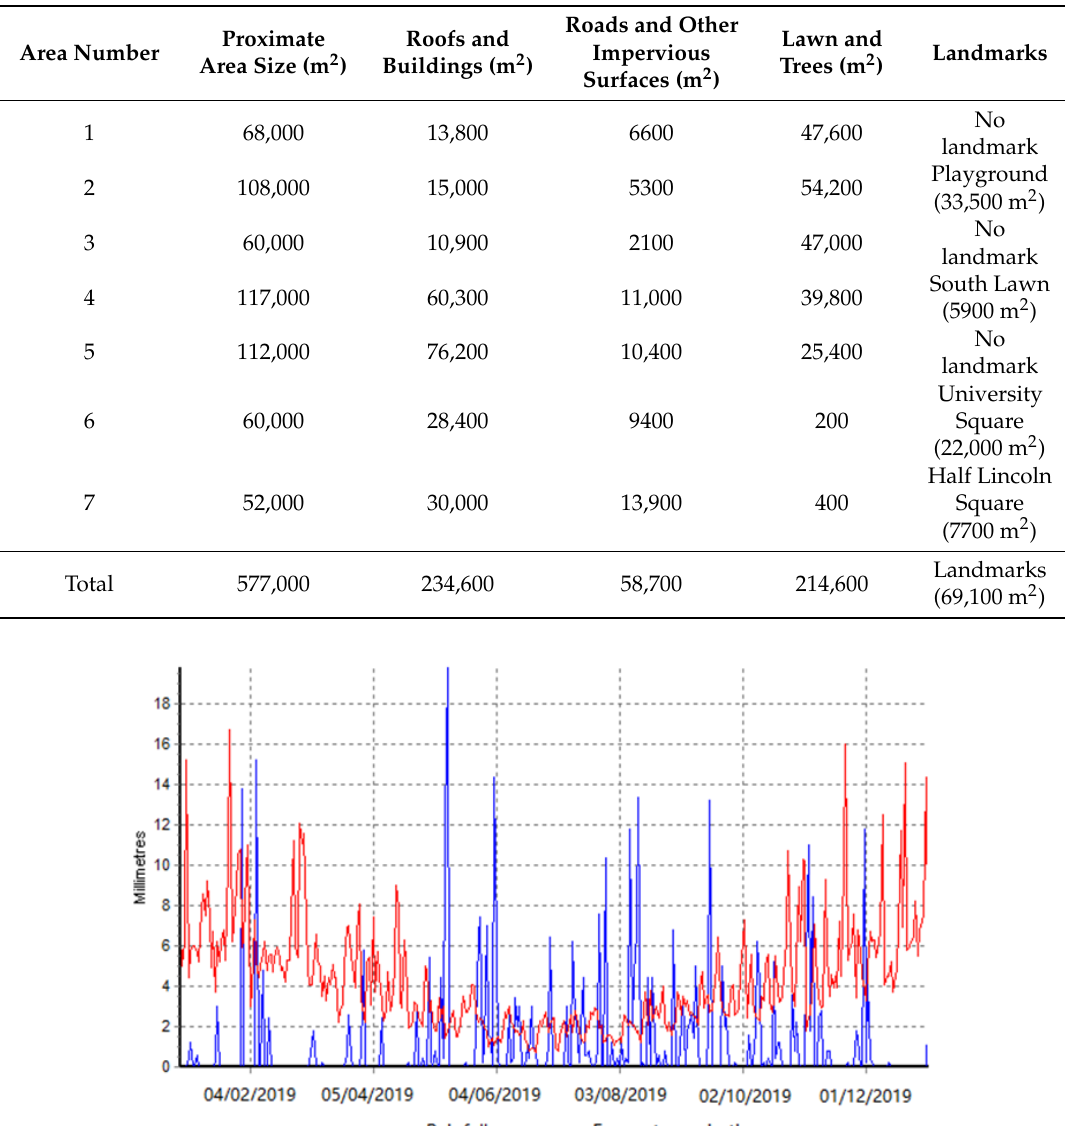
Table 5. Gaussian Distribution parameters of pollutants total suspended solid (TSS), total phosphorus (TP), and total nitrogen (TN).